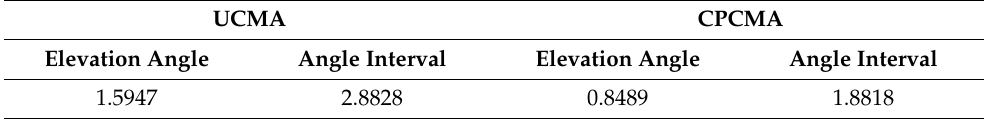
Table 8. RMSE in inner race defect located by both arrays at 290